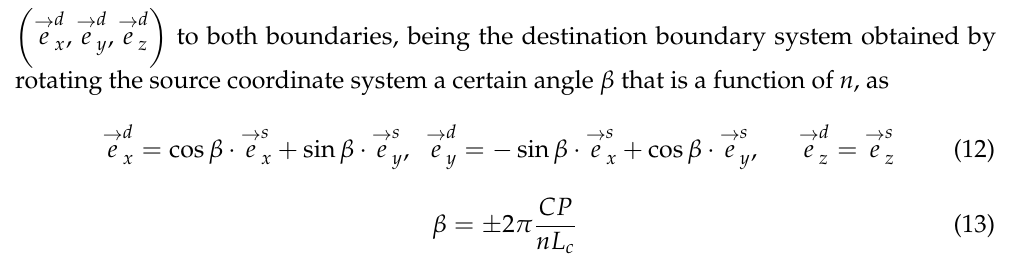
Table 1. Main parameters of a 115 kV, 240 mm 2